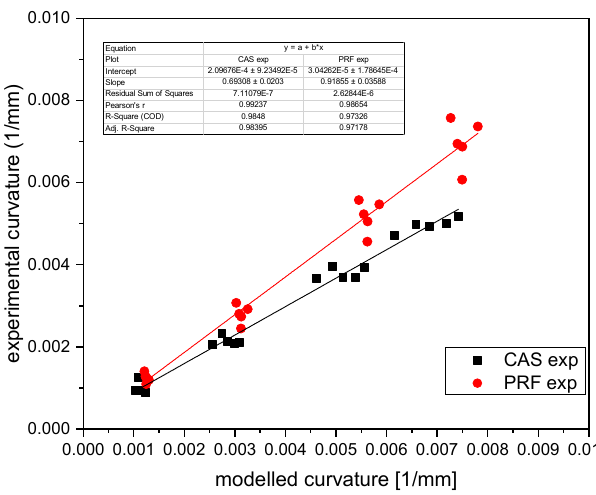
Figure 6. Prediction of simple Timoshenko-model with density-dependent strains.